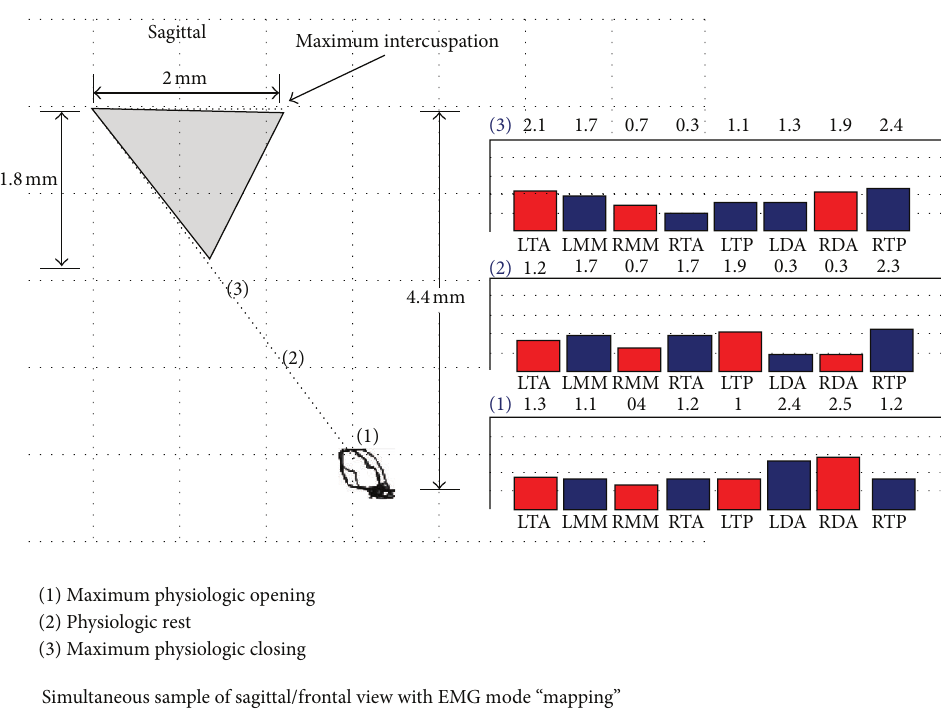
Figure 1: Adapted and modified from [26, page 9]. SEMG of the temporalis anterior (TA), masseter (MM), temporalis posterior (TP), and suprahyoid (DA) sites in combination with incisal spatial kinematics. “Maximum physiologic opening” or the bottom of the physiologic zone (incisal position 1) was determined when the suprahyoid activity was above what was determined as normal levels. The top of the zone or “maximal physiologic closing” (incisal position 3) was determined when elevator activity increased to greater than what was determined as physiologic normal levels. Physiologic rest (incisal position 2) position after 45–60 minutes of